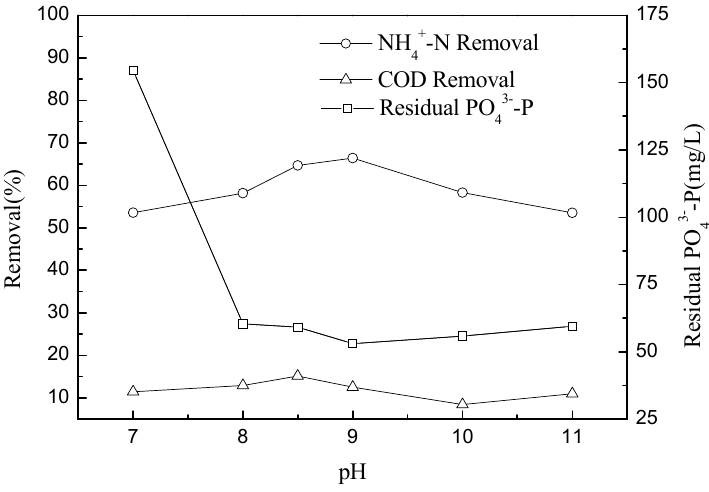
Figure 4. Effect of pH on NH 4+ -N and COD removals, residual PO 43 − -P at Mg 2+ :NH 4+ -N: PO 43 − -P molar ratio of 1:1:1 and mixing time 15